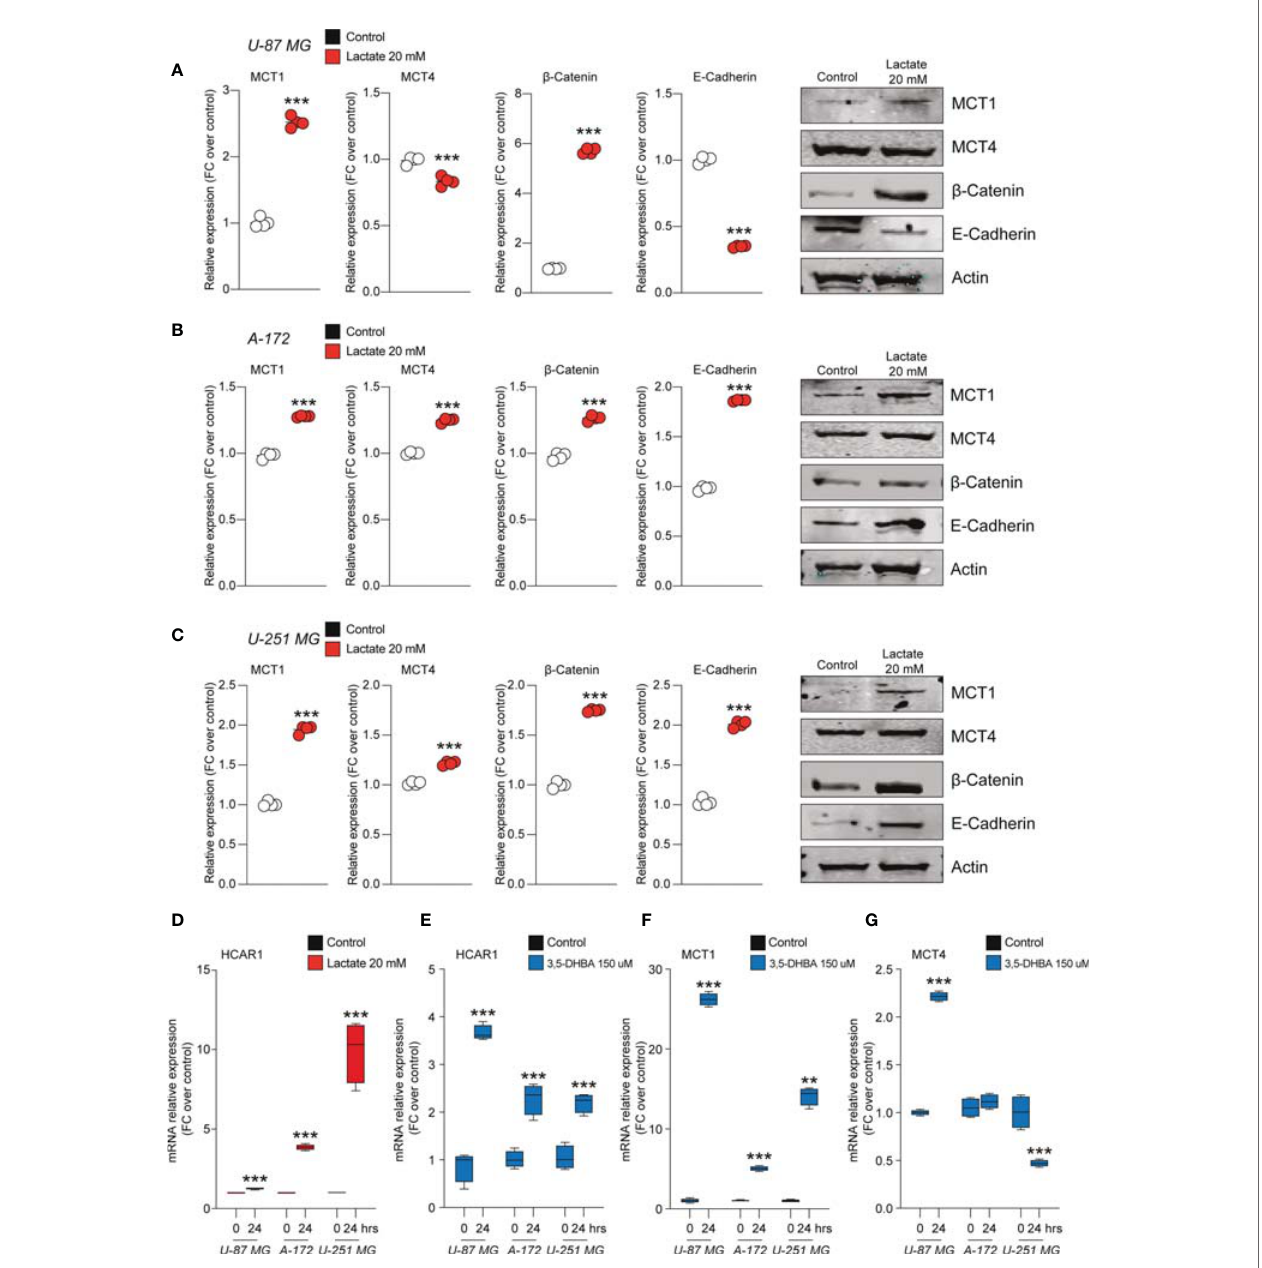
FIGURE 3 | Lactate regulated the expression of monocarboxylate transporters (MCTs) and epithelial – mesenchymal transition (EMT) markers in glioblastoma cells. (A – C) Protein expressions of MCT1, MCT4, b -catenin, and E-cadherin in U-87 MG cells (A) , A-172 cells (B) , and U-251 MG cells (C) following 72 h of lactate (20 mM) treatment. The fi gures presented are representative of at least four independent experiments, and values represent the mean ± SEM of experiments performed in quadruplicate. (D) HCAR1 gene expression in U-87 MG, A-172, and U-251 MG cells following 24 h of lactate (20 mM) treatment. (E – G) Gene expressions of HCAR1 (E) , MCT1 (F) , and MCT4 (G) in U-87 MG, A172, and U-251 MG cells following 24 h of 3,5-dihydroxybenzoic acid (3,5-DHBA, 150 m M) treatment. Values represent the mean ± SEM of experiments performed in quadruplicate. P -values <0.05 were considered as statistically signi fi cant (** p < 0.01; *** p < 0.001 vs .